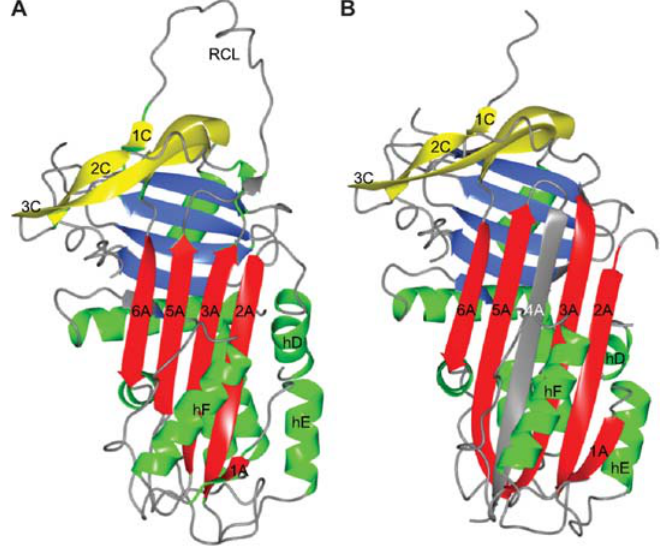
Figure 1 Sketch representation of (A) native and (B) cleaved hNS. The A-, B- and C-sheets are colored red, blue and yellow, respectively; the helices are green and coil regions including the RCL are colored gray (see also Figure 3). b -Strands and a -helices are labeled according to the standard serpin